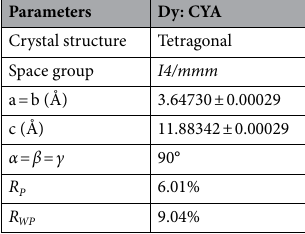
Table 1. The parameters of refined structure.